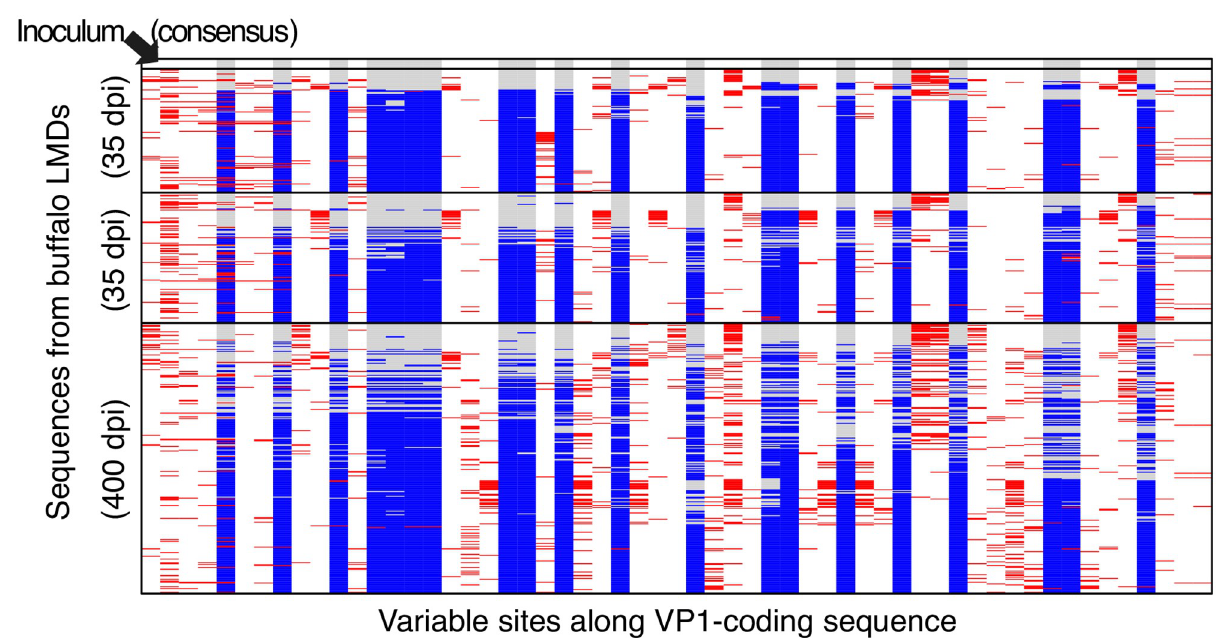
Fig 3. Illustration of the genetic structure of of the VP1-coding sequences from Laser Micro-Dissections (LMDs) of buffalo tissues. Each row represents the genetic content of a sequence and each column represents a SNV. The alleles are illustrated by the following colors: grey (consensus alleles of the inoculum), blue (alleles of the minor sub-population in the inoculum), white (alleles in common between both sub-populations) and red (new mutations with respect to the consensus sequences of the two sub-populations). Sequences are sorted by animal, then by divergence from the consensus sequence of the inoculum (shown at the top); the two sub-populations correspond therefore to the upper (grey-dominated) and lower (blue- dominated) sequences for each animal.